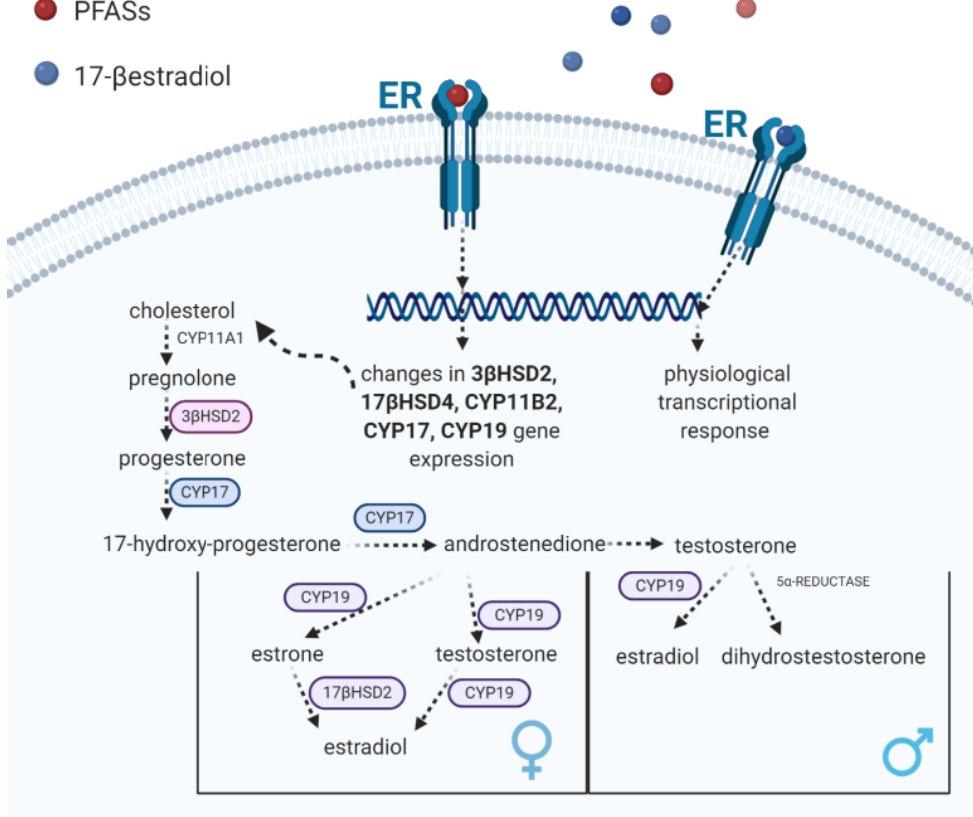
Figure 4. Transcriptional regulators of the cholesterol transformations via ER in male and female–implications caused by PFASs. ER, endocrine (nuclear) receptor.